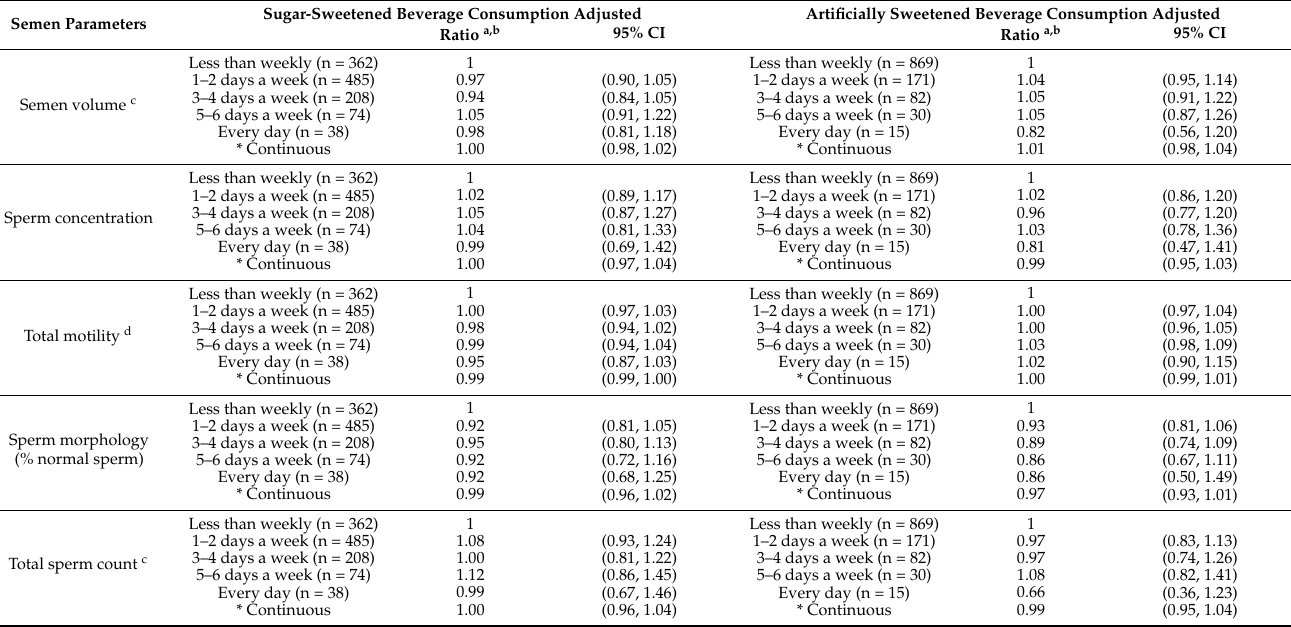
Table 4. Adjusted outcome ratios according to sugar-sweetened and artificially sweetened beverage consumption among participants, FEPOS